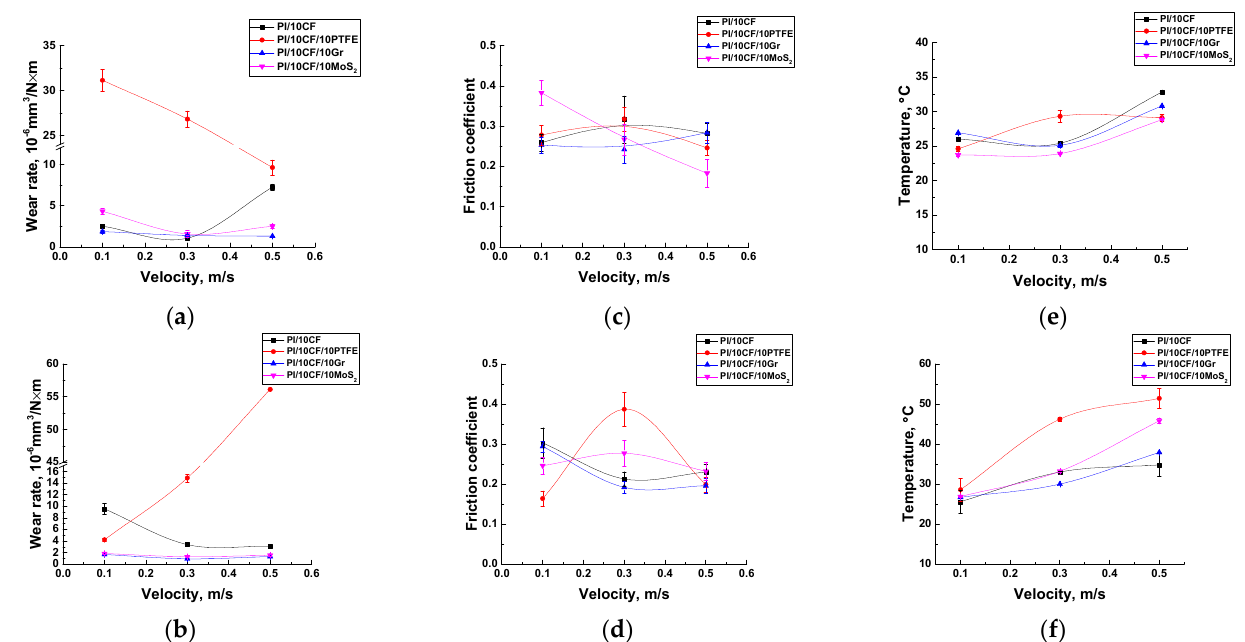
Figure 13. Wear rates ( a , b ), the friction coefficients ( c , d ), and the counterpart temperature ( e , f ) for the PI-based composites vs sliding speed: ( a , c , e )— P = 60 N; ( b , d , f )— P = 180 N.